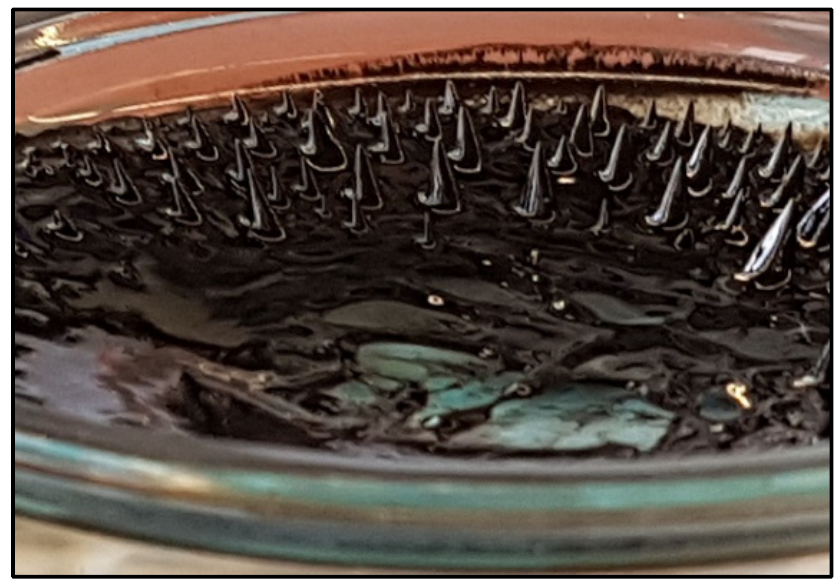
Figure A2. Observed Rosensweigin stability in the prepared Ferrofluid.